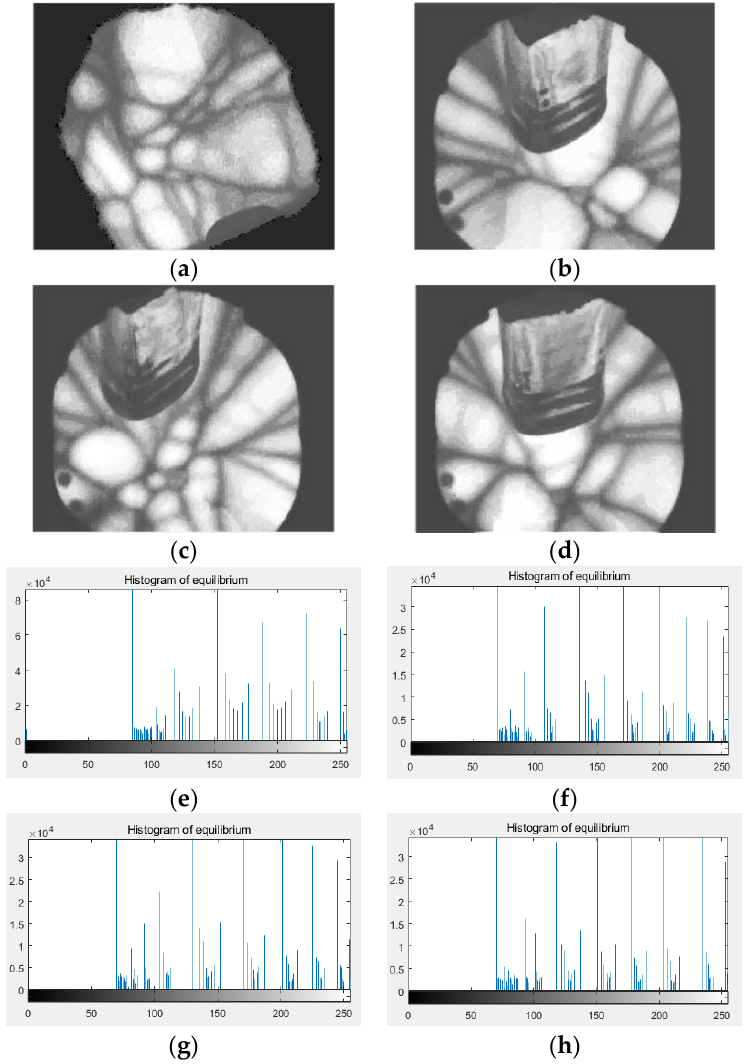
Figure 6. ( a – d ) are images after image enhancement, ( e – h ) are the histograms of images after image enhancement.